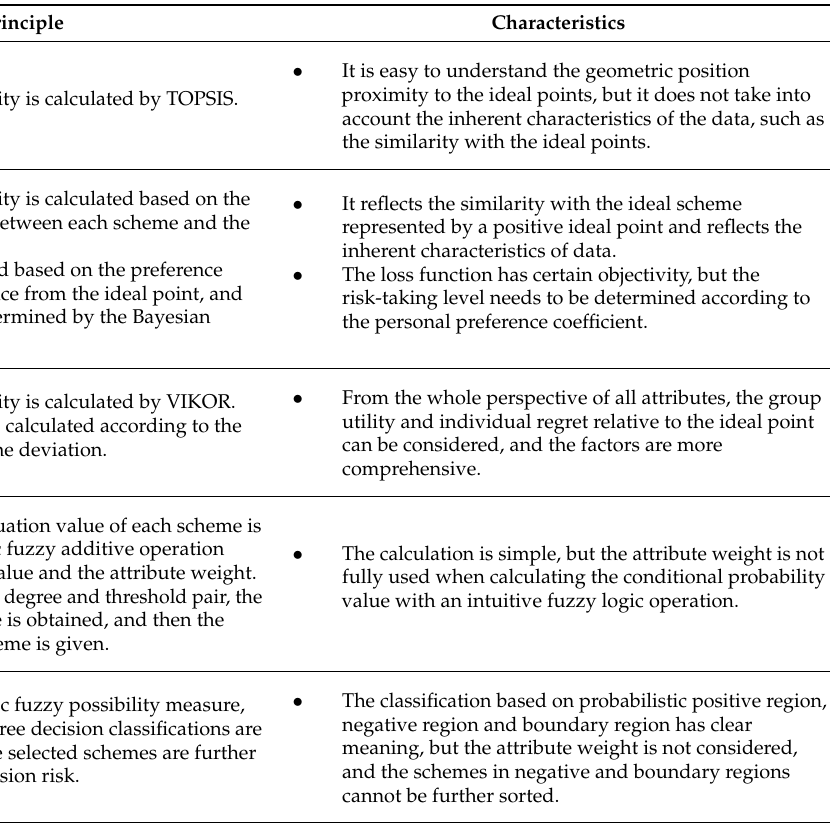
Table 1. The representative three-way decision methods under intuitionistic fuzzy or interval-valued intuitionistic fuzzy multi-attribute